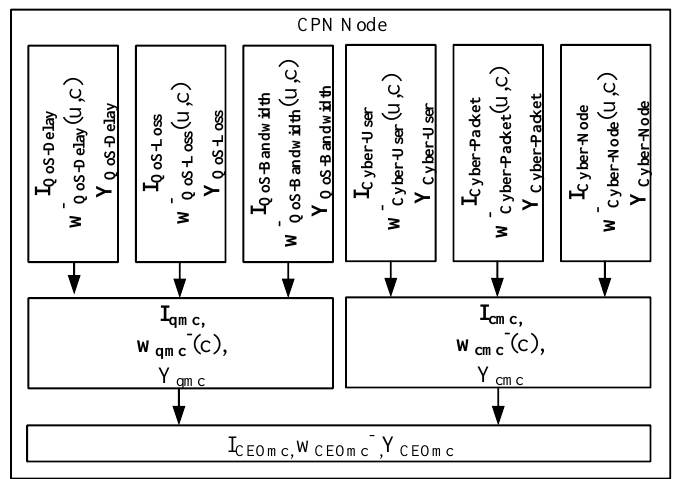
Figure 7. CPN node with Deep Learning clusters model.